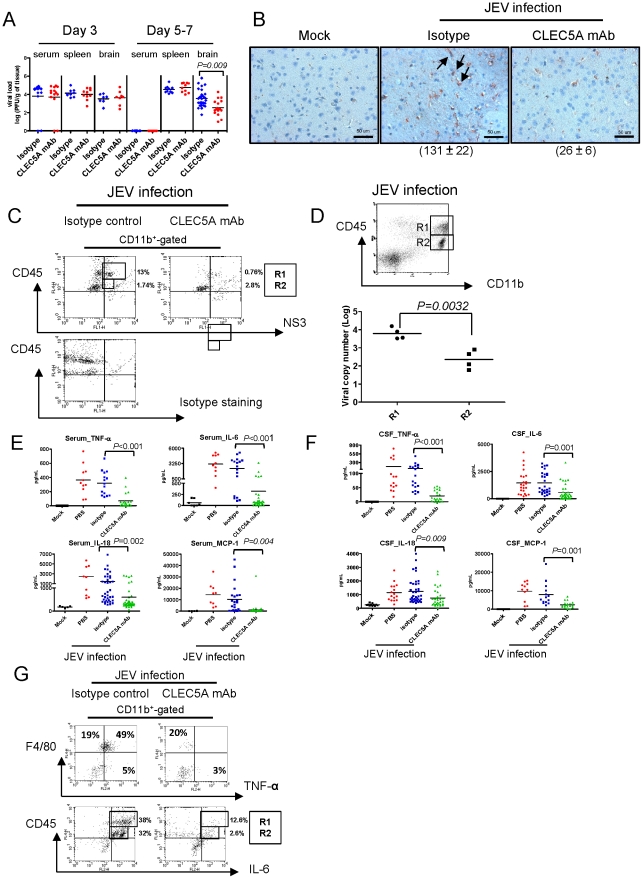
Anti-CLEC5A mAb reduces viral load in the CNS and attenuates CNS inflammation.(A) Viral titer was determined by plaque assay for sera and tissue homogenates from JEV infected mice with or without anti-CLEC5A mAb treatment (two-tailed Student's t-tests). (B) The extent of NS3 expression in the cortex was diminished after peripheral administration of anti-CLEC5A mAb at day 5 post JEV infection. Scale bars, 50 µm. Five random fields of views in medium power field (original magnification (OM)×200) were photographed, and the numbers of NS3+ cells in each sample were counted, summed up and represented as mean ± s.e.m. (under each picture) of four independent experiments. (C) Numbers of NS3+ leukocytes (CD45hiCD11b+ and CD45midCD11b+) in JEV-infected brain were significantly reduced by administration of anti-CLEC5A mAb at day 5 post JEV infection. (D) Quantification of viral copies in CD45hiCD11b+ (R1) and CD45lowCD11b+ (R2) cells sorted from the brain of JEV-infected mice. The average of total cell numbers in R1 and R2 were approximately 5×104 and 2×104, respectively, in the isotype treated group. Q-PCR assay was performed on total RNA from each population and normalized with its respective internal control. Data were collected from four independent experiments. Two-tailed Student's t-tests were performed. Cytokines levels in the sera (E) and CSF (F) were measured by ELISA at day 5–7 post JEV infection. The effects of CLEC5A mAb (3E3G4) and isotype control were compared using two-tailed Student's t-tests. (G) Intracellular TNF-α and IL-6 were detected in CD11b+ gated F4/80+ and CD45+ cells isolated from JEV-infected brain by flow cytometry.